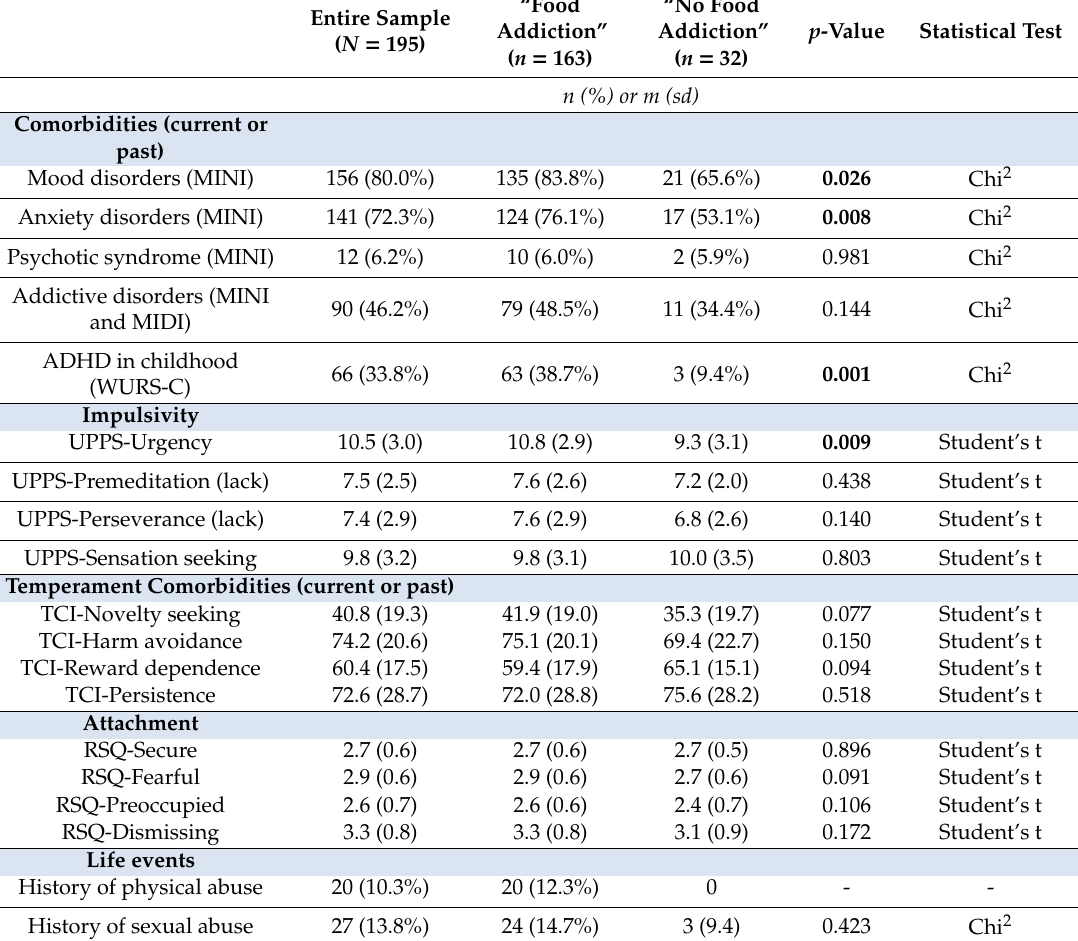
Table 3. Description of the sample and comparison of the patients with “Food Addiction” or “No Food Addiction” ( n = 195)—Other clinical